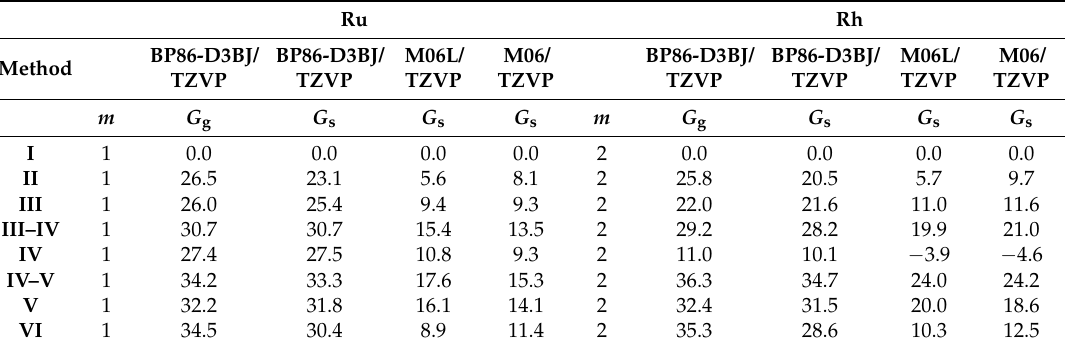
Table 1. Computed stationary points (Gibbs free energies in kcal/mol) for the olefin metathesis reaction pathway for M(SIMes)Cl 2 (=CHPh)PPh 3 (M = Ru and Rh) with ethylene as substrate ( m = multiplicity; 1 = singlet; 2 = doublet; g = gas; s =